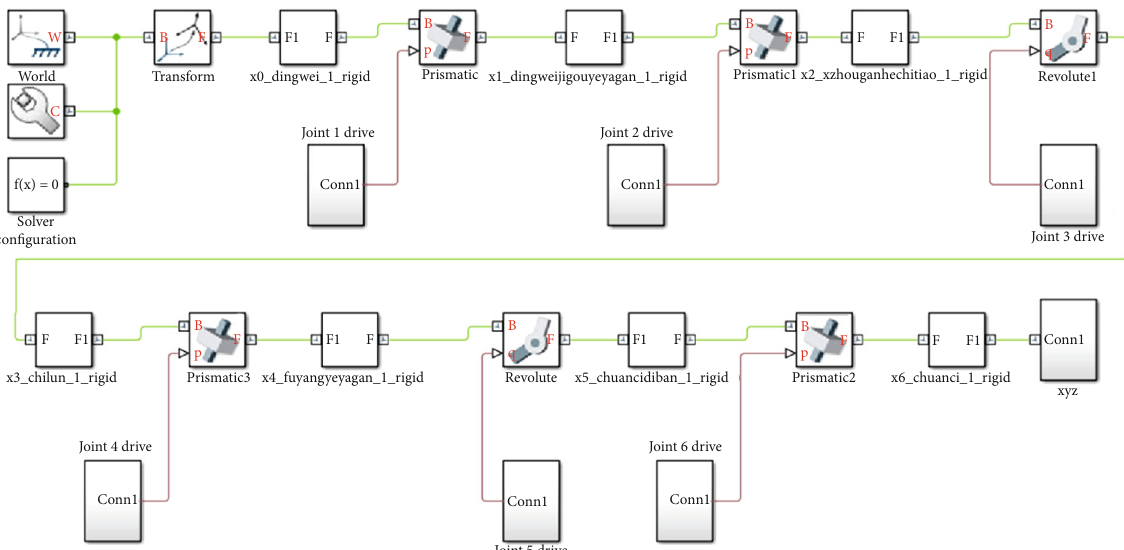
Figure 9: MRI-compatible breast interventional robot system simulation model.